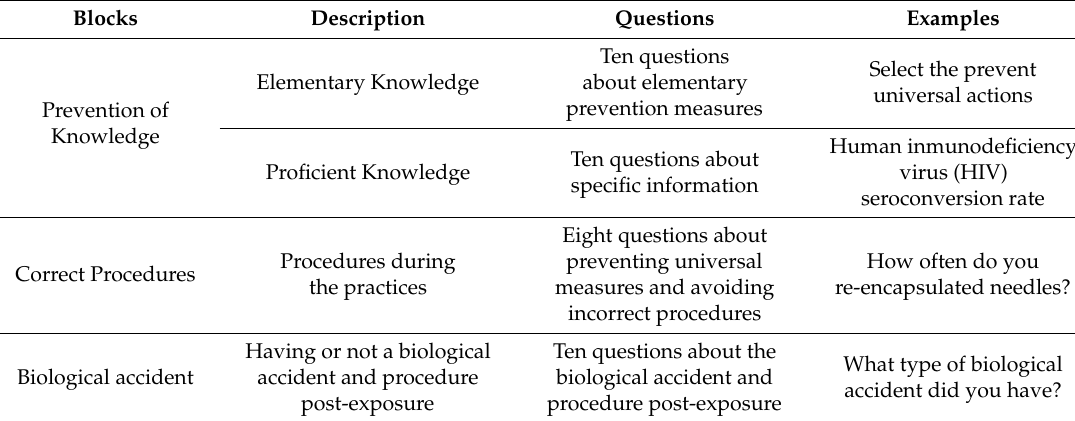
Table 1. Structure of the survey used on the